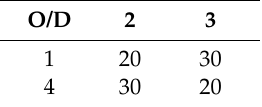
Table 4. OD demand.